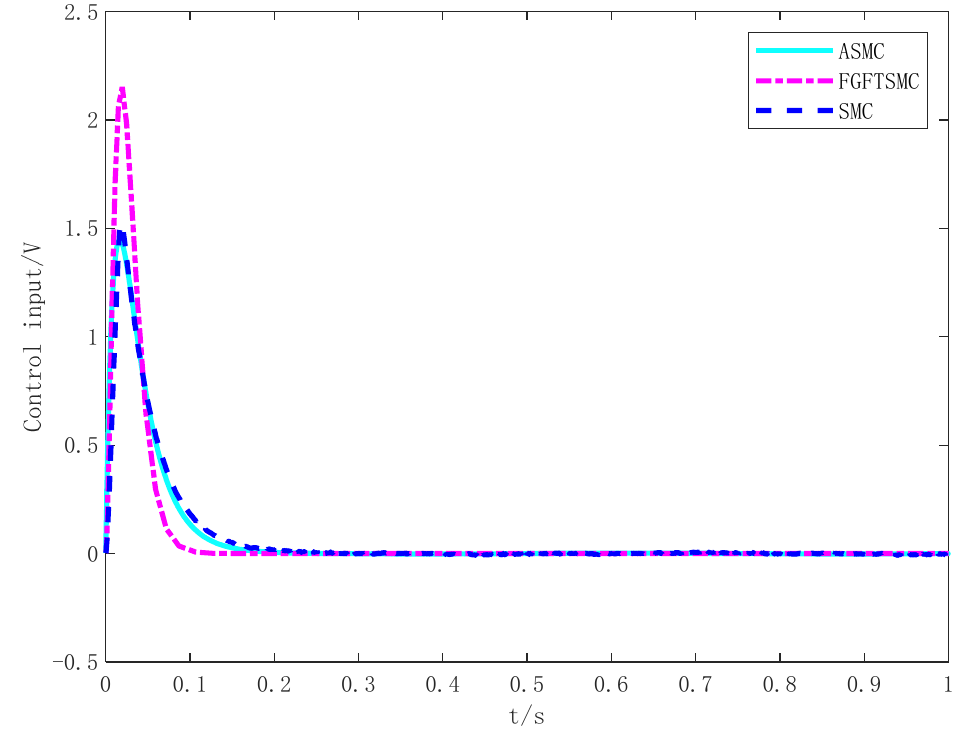
Figure 6. Control output comparison. signals, the given signal is chosen as y d = 0.5 cos ( 10 π t ) mm , and the controller parameters are designed as: α 0 = 150, α 1 = 100, p = 5, q = 3, p 0 = p 1 = 9, q 0 = q 1 = 1, ϕ = 1000, θ = 2000, ρ 1 = 1 × 10 − 12 , ρ 2 = 1 × 10 − 13 , ρ 3 = 1 × 10 − 6 , λ = 0.75, c 1 = c 2 = 10, β 0 = β 1 = 1 × 10 − 15 . The simulation results are shown in Figures 7–9.